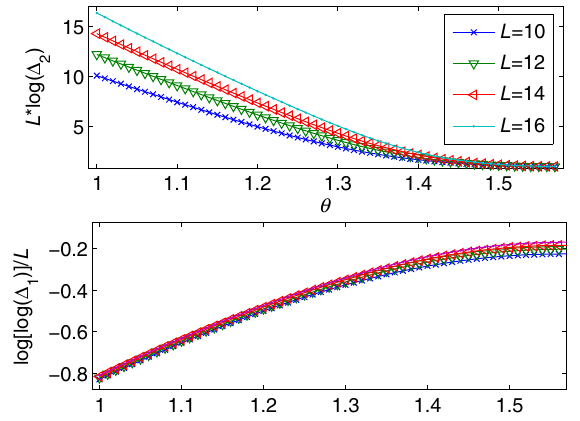
FIG. 23. Upper panel: The second gap of the TM represented in Fig. 22(b) in the Z 2 spin-liquid phase closes as θ approaches π = 2 , where there is the transition from the Z 2 spin-liquid phase to the U ð 1 Þ algebraic spin-liquid phase. The collapse of the data for the Δ π = 2 , for the values of L in the range L ¼ 10 ; … ; 16 , 2 L close to confirms that the gap at the transition closes as 1 =L as